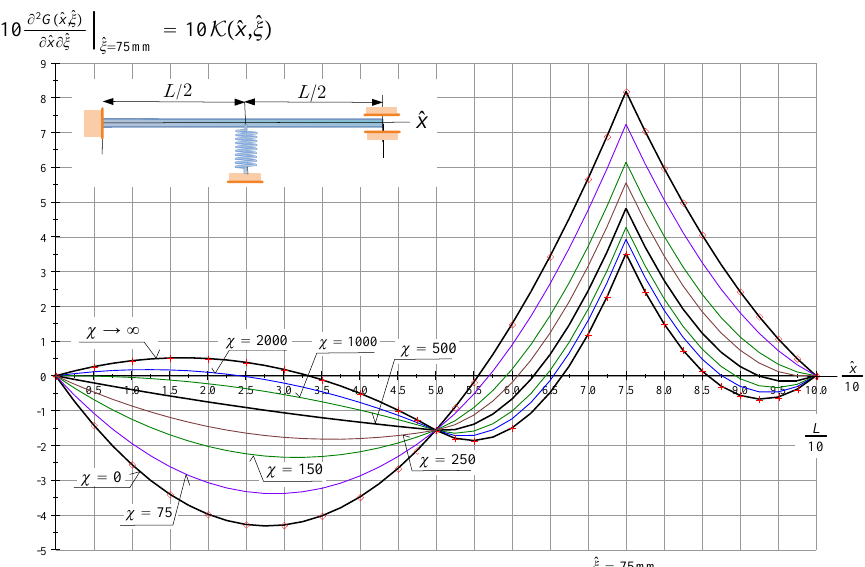
Figure 5. The kernel function of an FssF beam against x = ˆ x / L ; χ is a parameter and ξ = 0.75.